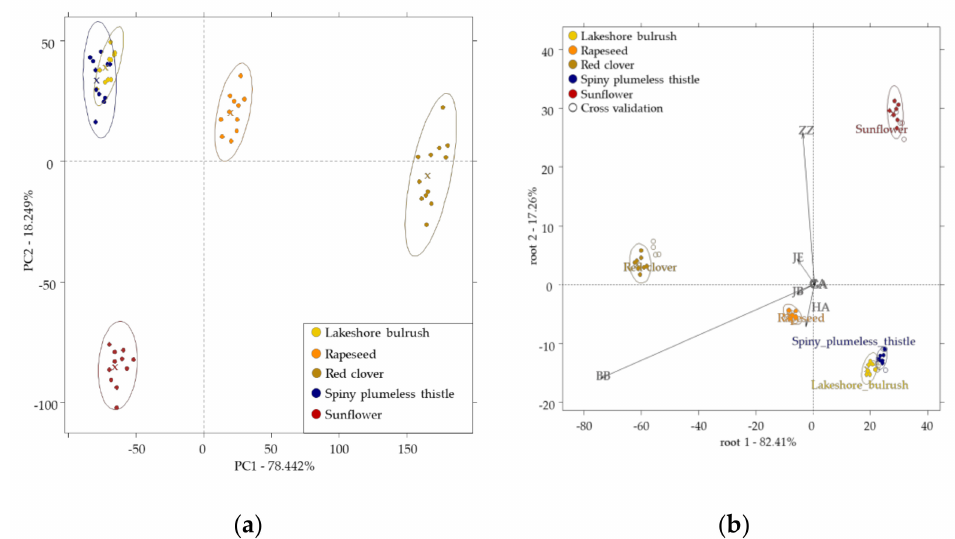
Figure 4. Results of the electronic tongue using all the methods ( n = 55): ( a ) PCA score plot; ( b ) LDA score plot built for the classification of botanical groups with 95% confidence interval ellipses after additive correction relative to all samples. x denotes the center of the ellipses, on figure ( b ) solid point are for the training set, and hollow points are for the validation set.